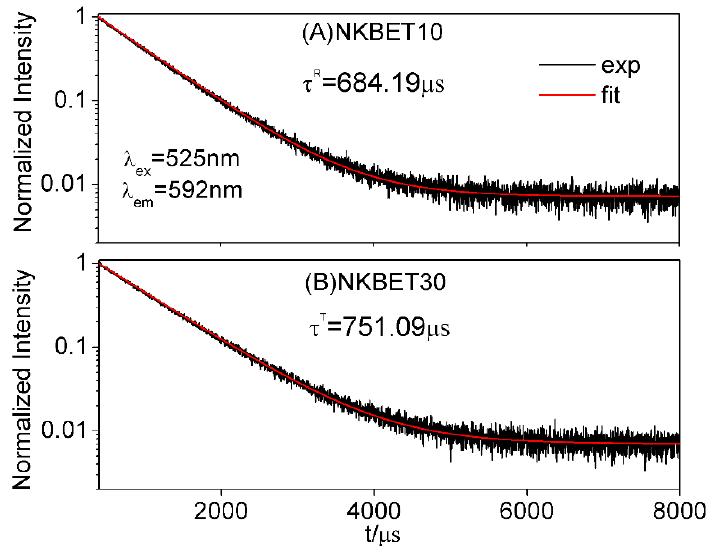
Figure 3. The decay curve of the ceramic powders of ( A ) NKBET10 and ( B ) NKBET30. The excitation wavelength is 525 nm and the monitored luminescence wavelength is 592 nm. The monoexponential function, I ( t ) = I ( 0 ) exp ( − t / τ ) , was used to fit the decay curve in order to obtain the decay time.